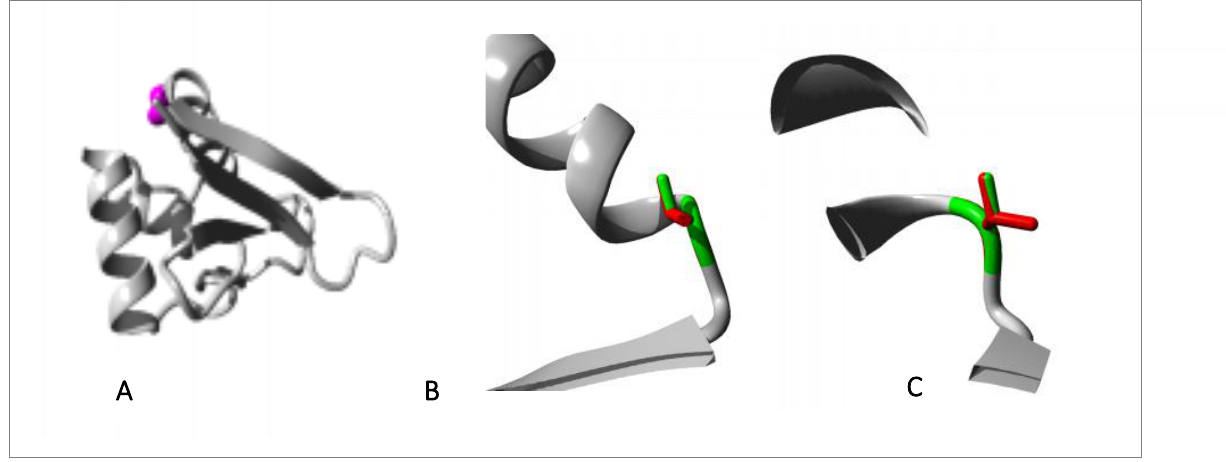
Figure 3. Images representing parts of the protein structure with the mutant residue. A. Ribbon overview of the protein, in gray, with the mutant residue represented in purple. B and C. Detailed view of the representation of the side chains of the mutant amino acid residue, in red compared to the wild residue, in green. Source: generated by the HOPE tool